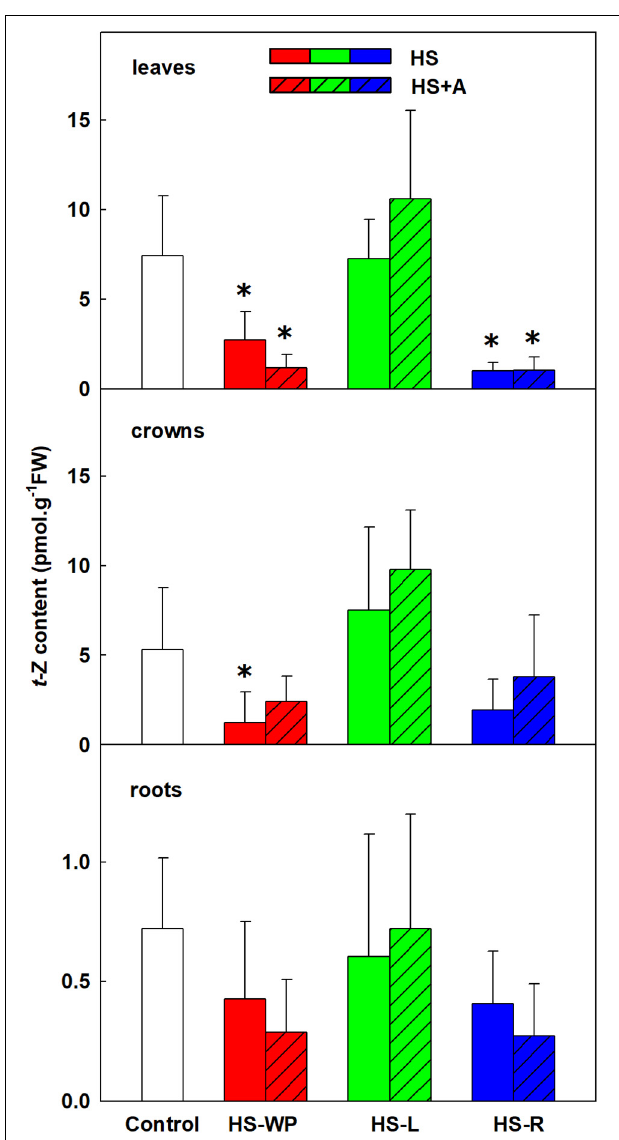
FIGURE 7 | The content of cytokinin cis- zeatin (cZ) in leaves, crowns and roots of rice seedlings exposed to heat stress directly (HS) or after acclimation (HS + A). Heat stress was applied to whole plants (HS-WP), to leaves (HS-L), or to roots (HS-R). Data are means ± SD. One-way ANOVA with Tukey’s post hoc test ( p < 0.05, n = 6) was used to compare controls to the HS treatments. Significant differences compared to control plants are indicated by asterisks ( ∗ ) while crosses (+) indicate significant differences between HS and HS + A